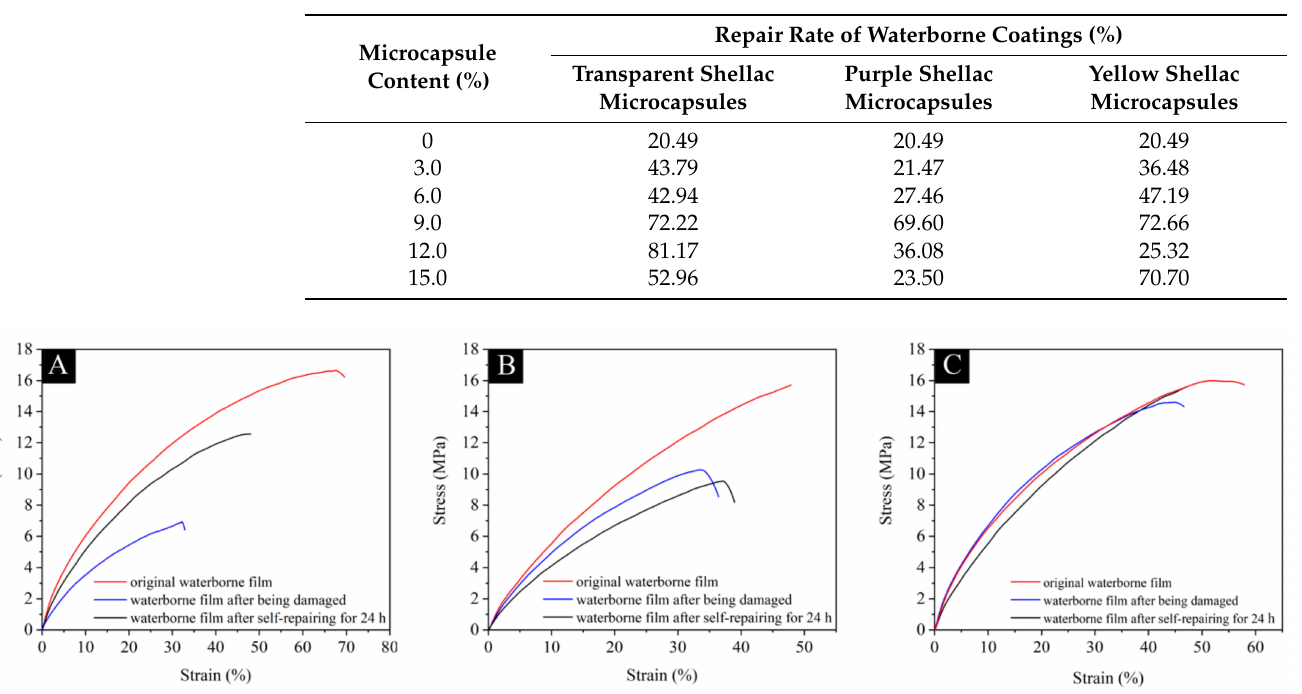
Table 6. The results of the repair rate of waterborne coatings with three kinds of shellac microcapsules.